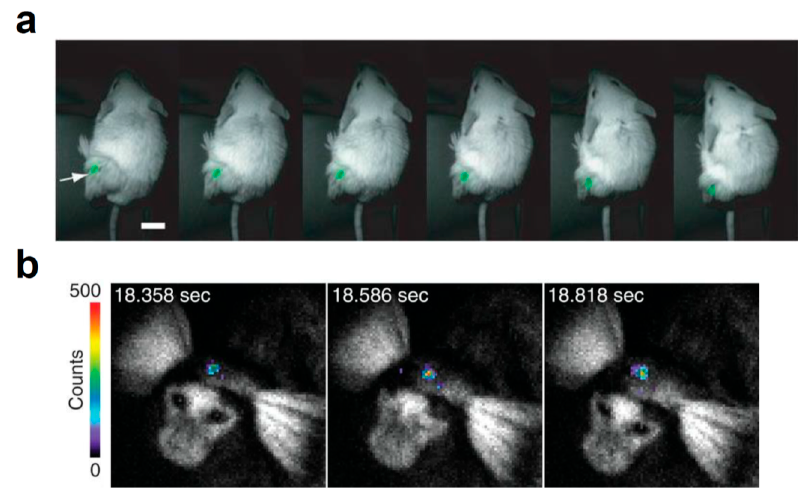
Figure 4. In vivo BLI with brighter or red-shifted bioluminescence systems. ( a ) Video-rate BLI of Nano-lantern-expressing tumor cells in an unshaved mouse; Scale bar, 1 cm. Reprinted with permission from ref. [34]. White arrow indicates the luminescence signal from Nano-lantern-expressing cells. Copyright 2012 Nature Publishing Group. ( b ) AkaBLI with 4-year-old female marmoset expressing AkaLuc in the right striatum 12 months after injection. Reprinted with permission from ref. [18]. Copyright 2018 The American Association for the Advancement of Science.